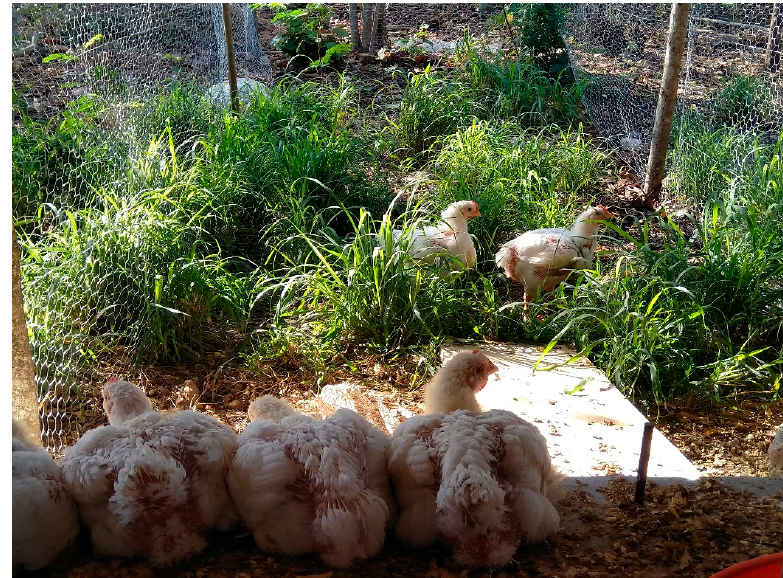
Figure 2. View of the outdoor area from inside a pen.